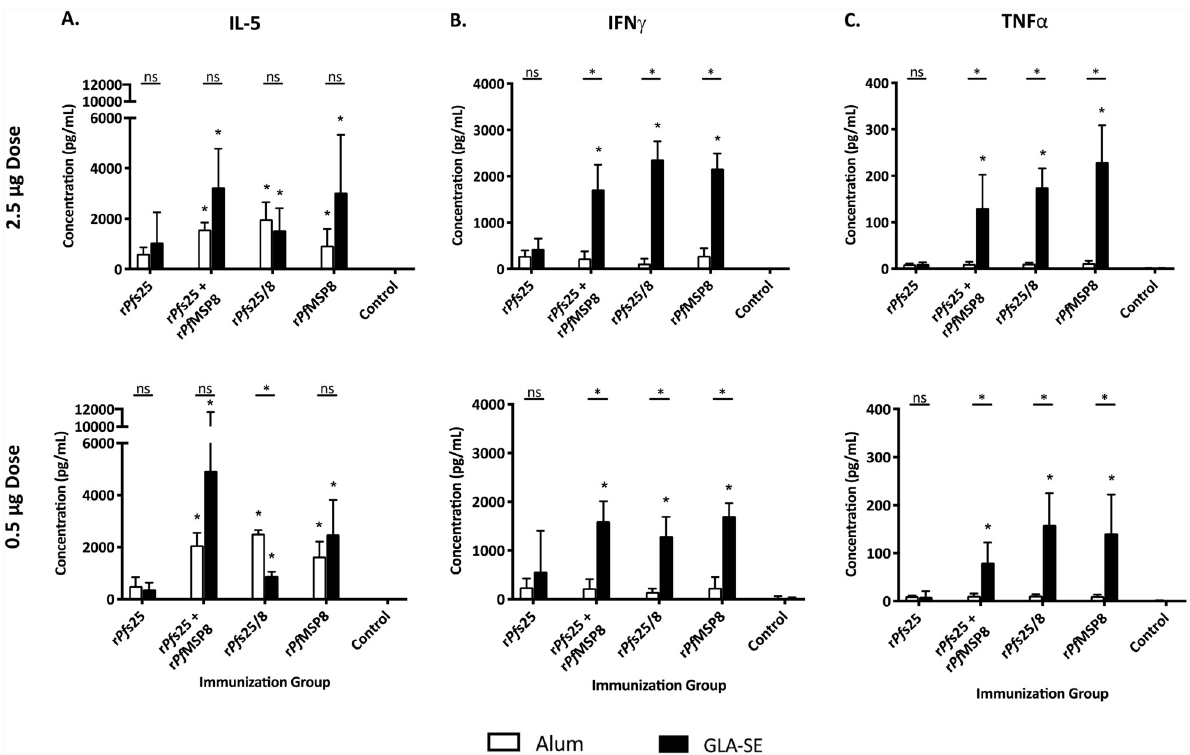
Fig 2. Cytokine production by CD4 + T cells reveals different T helper profiles as a function of adjuvant in a Pf MSP8-dependent manner. Splenocytes (5 x 10 5 /well) were harvested from groups of CB6F1/J mice immunized as indicated and stimulated ex vivo in the presence of r Pf s25/8 (2 μ g/well) or in media alone for 96 hours. Culture supernatants were collected and analyzed for production of A) IL-5, B) IFN γ and C) TNF α using a multiplex assay (Luminex 1 ). To calculate the final concentration of each analyte, levels found in the corresponding unstimulated conditions were subtracted as background. Graphs depict the mean concentration of each analyte +/- standard deviation. Asterisks directly over single bars represent significant differences between the indicated groups compared to the corresponding adjuvant control group (Kruskal-Wallis Test; P < 0.05 considered significant). Asterisks over horizontal lines signify significant differences between the two indicated groups (Mann-Whitney U test; P < 0.05 considered significant; ns, not